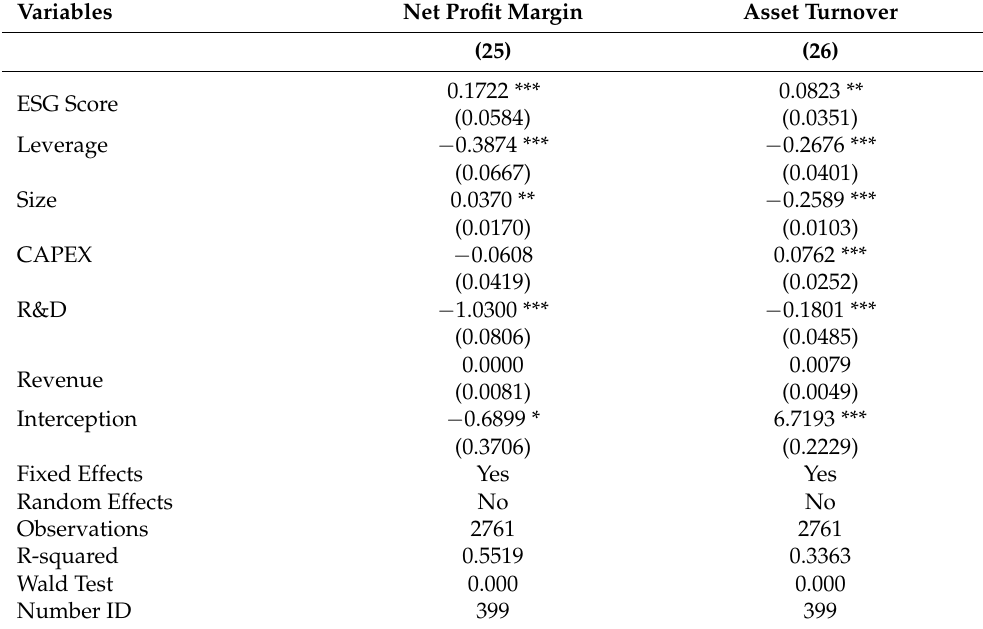
Table 7. Fixed and random effects specifications: channels of economic performance.